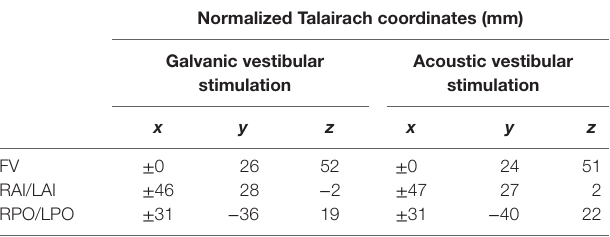
TaBle 1 | Talairach consensus coordinates obtained by sequential and anatomical seeding of regional sources in brain-evoked source analysis (BESA) for galvanic vestibular stimulation in comparison to those obtained in acoustic vestibular stimulation in the previous study. normalized Talairach coordinates